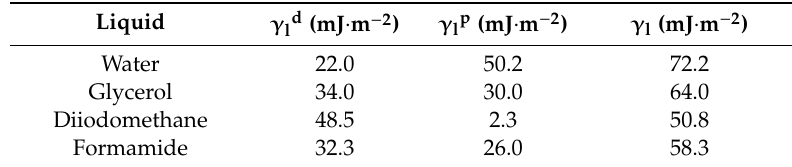
Table 2. Characteristics of the di ff erent liquids used in the contact angle measurement for determining the energy surface samples of